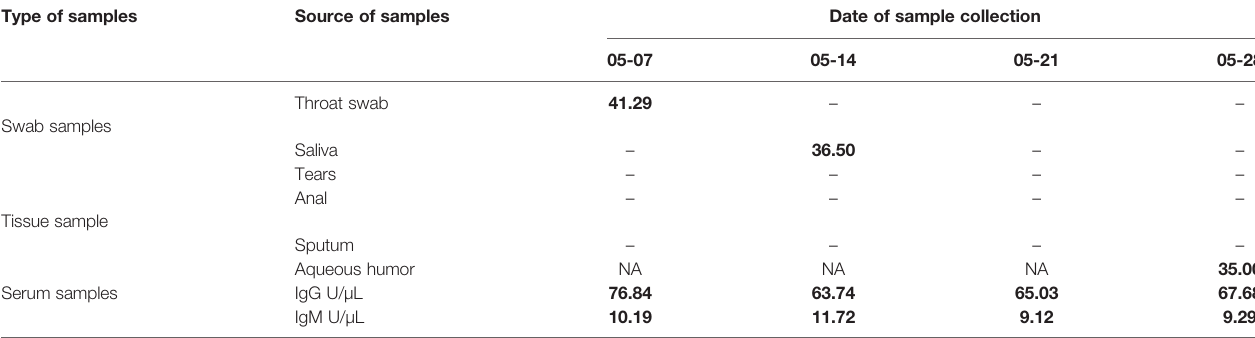
TABLE 1 | RT-qPCR results and antibodies titer calculated for four consecutive weeks. Type of